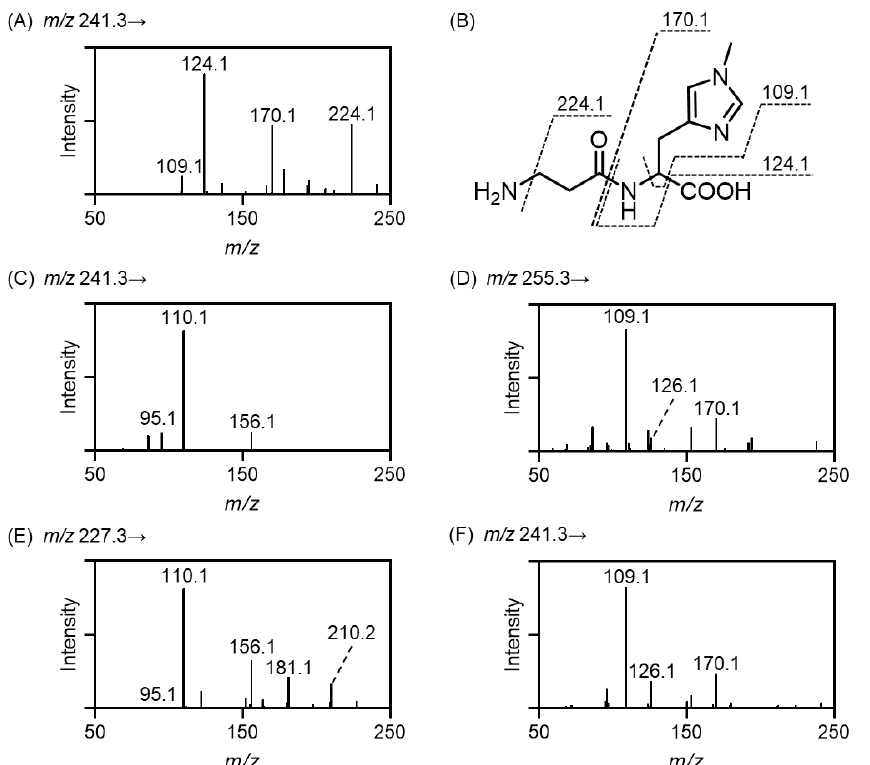
Figure 1. MS/MS spectra of IDPs. IDPs were synthesized by the carbodiimide coupling reaction and subjected to HPLC-ESI-MS/MS. MS/MS spectra of balenine ( A ), homocarnosine ( C ), homoanserine ( D ), carnosine ( E ), and anserine ( F ) are shown, respectively. Product ions of balenine were assigned as shown in ( B ). Table 1. MRM parameters for IDPs and stable isotope-labeled IDPs. Analyte